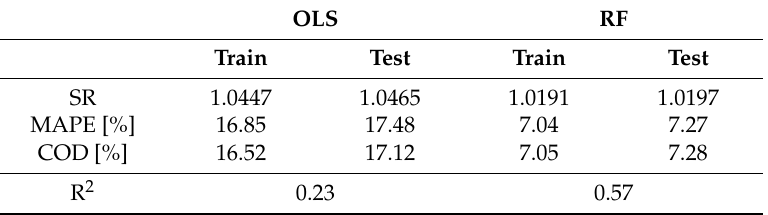
Table 3. Prediction accuracy for ordinary least square (OLS) and RF training and test data sets. OLS